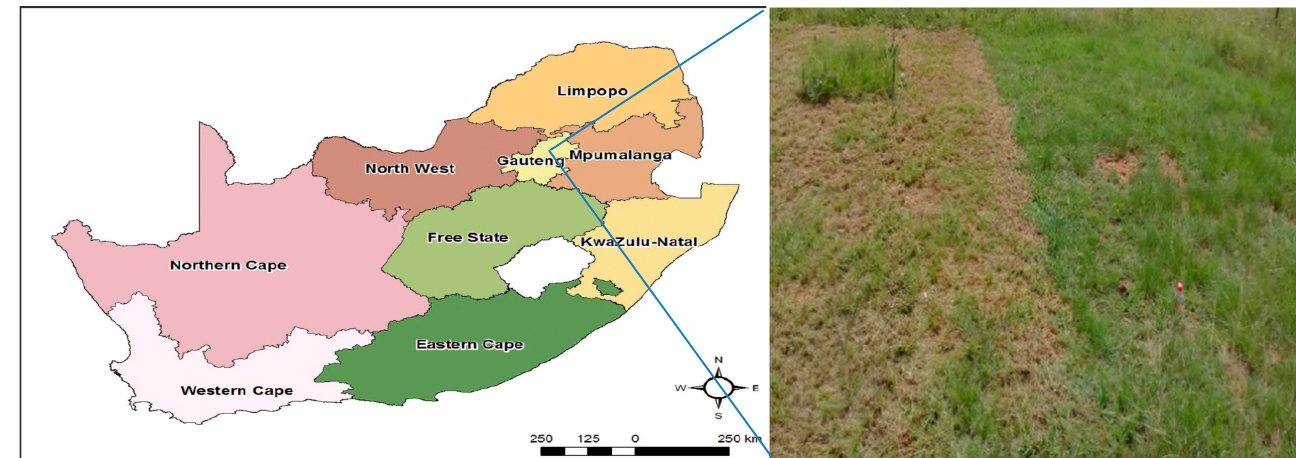
Figure 1. South Africa map showing study site (https://geology.com/, accessed 11 February 2021).